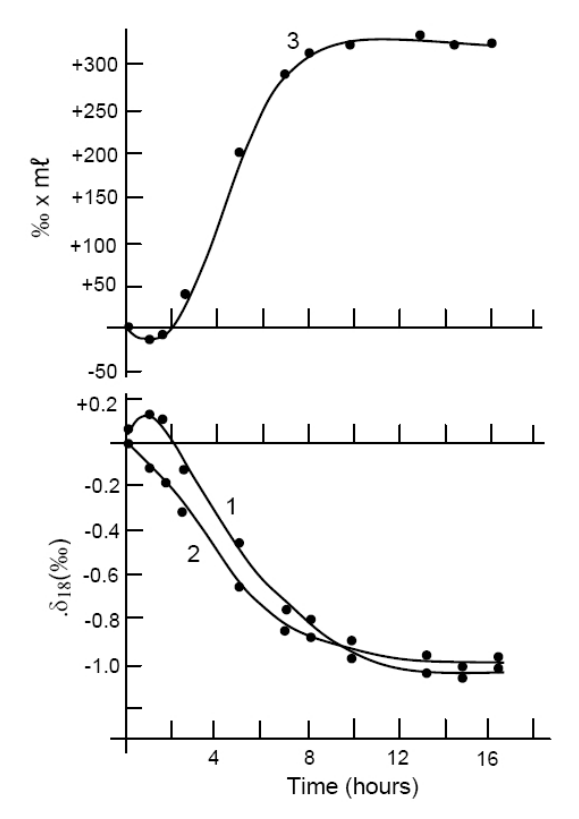
Fig. 13 Experiment with a thin membrane and elevated temperature in a hot cell. In- stallation fig. 5. membrane 30 μ , the temperature in the hot cell is 115 ◦ C, in the cold cell is 40 ◦ C, pressure 4 atm, hydraulic flow is 4 ml h − 1 . Initial water quantity in the hot cell is 200 ml; final quantity is 95 ml. The water quantity in the cold cell is constant - 160 ml. Curve 1 - δ value in the hot cell. Curve 2 - δ value in the cold cell. Curve 18 18 3 - an excess of isotopes are accumulated in the membrane according to isotope balance